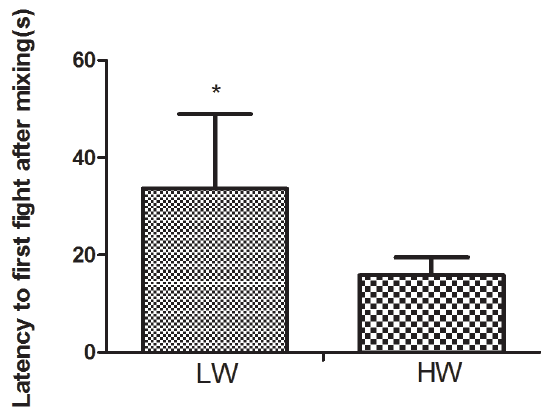
Figure 1. Comparison in latencies to the first fight after regrouping between the low litter weight (LW) and high litter weight (HW) litters. The asterisk (*) shows the significant difference with p<0.05; group means and standard errors are given in all figures.